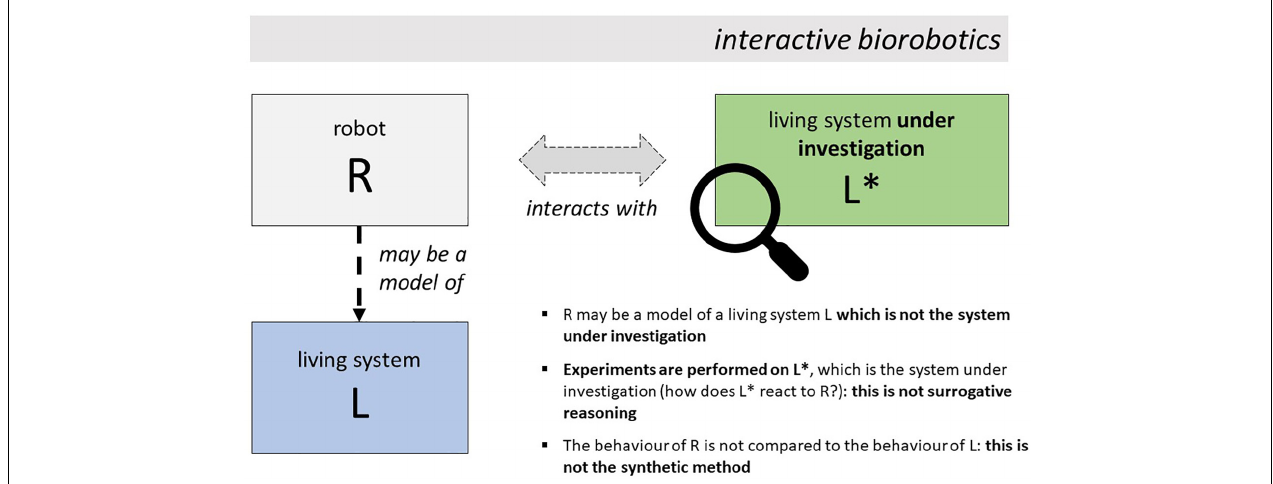
FIGURE 2 | In interactive biorobotics, the robot R may be a model of a living system L. However, it is not used to perform surrogative reasoning on it. Rather, it is used to study the behavior of another system, L*, with which it interacts in suitable experimental conditions.